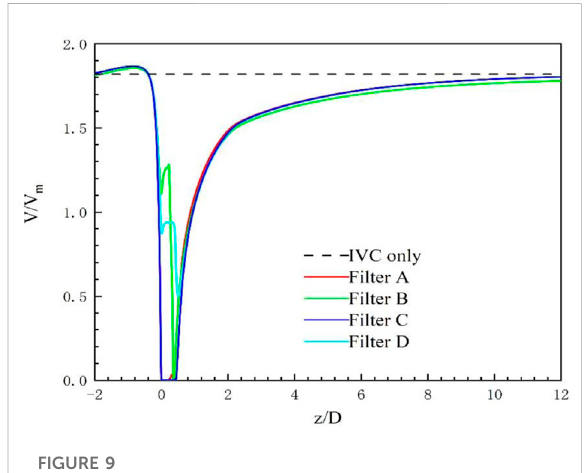
FIGURE 9 Blood fl ow velocity on the central line of the fi ve